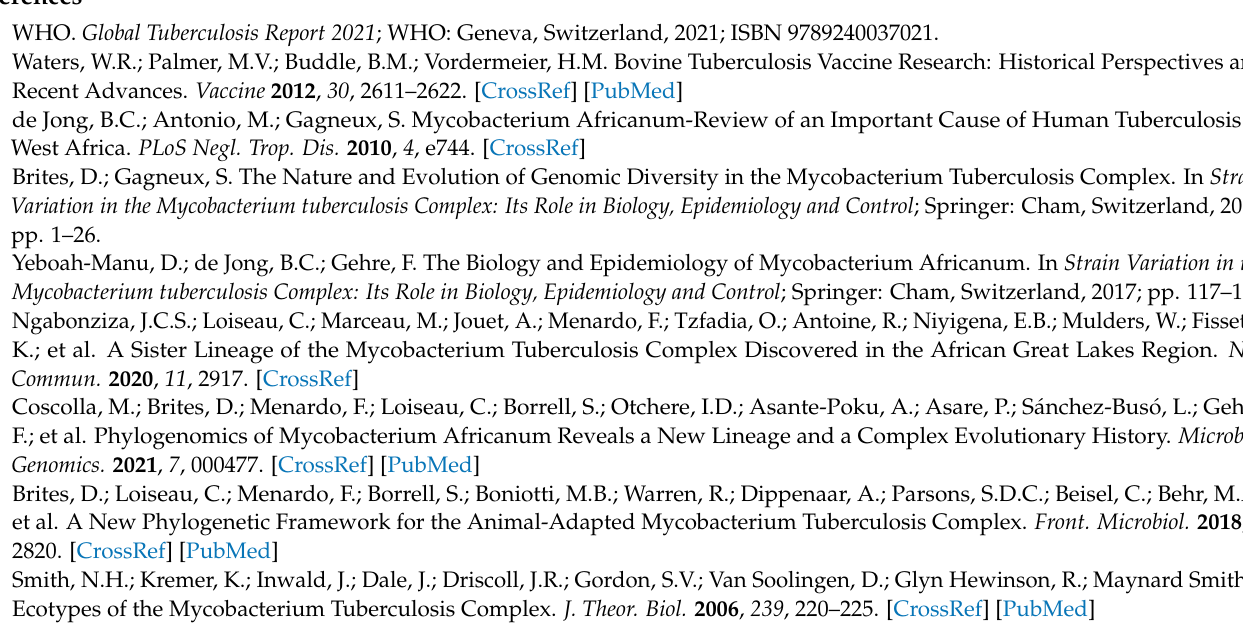
for each lineage’s model, Table S1: Illumina genomes information, Table S2: iEK1011 2.0 reaction information, Table S3: Removed reactions per lineage model, Table S4: OPLS-DA variable coefficients, Table S5: Statistically significant reaction fluxes between samples of animal- and human-associated models, File S1: Description of the genes removed from iEK1011 2.0 to generate lineage-specific GEMs, File S2: Lineage-specific genome scale metabolic